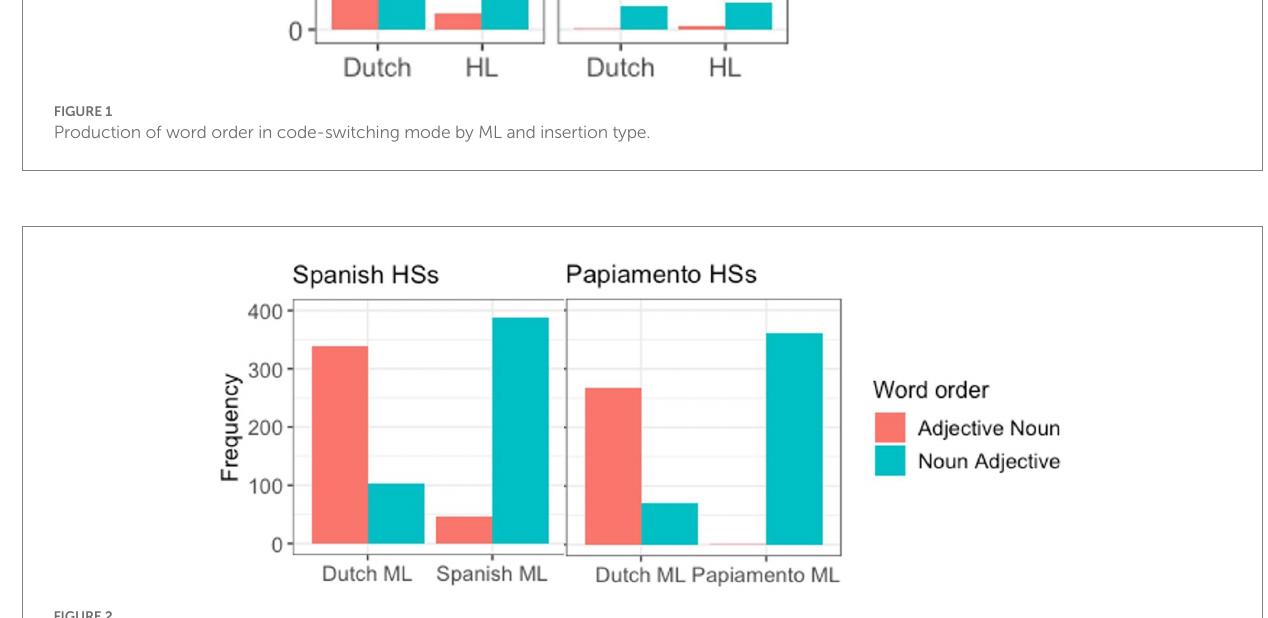
FIGURE 2 Production of word order by ML, separated between